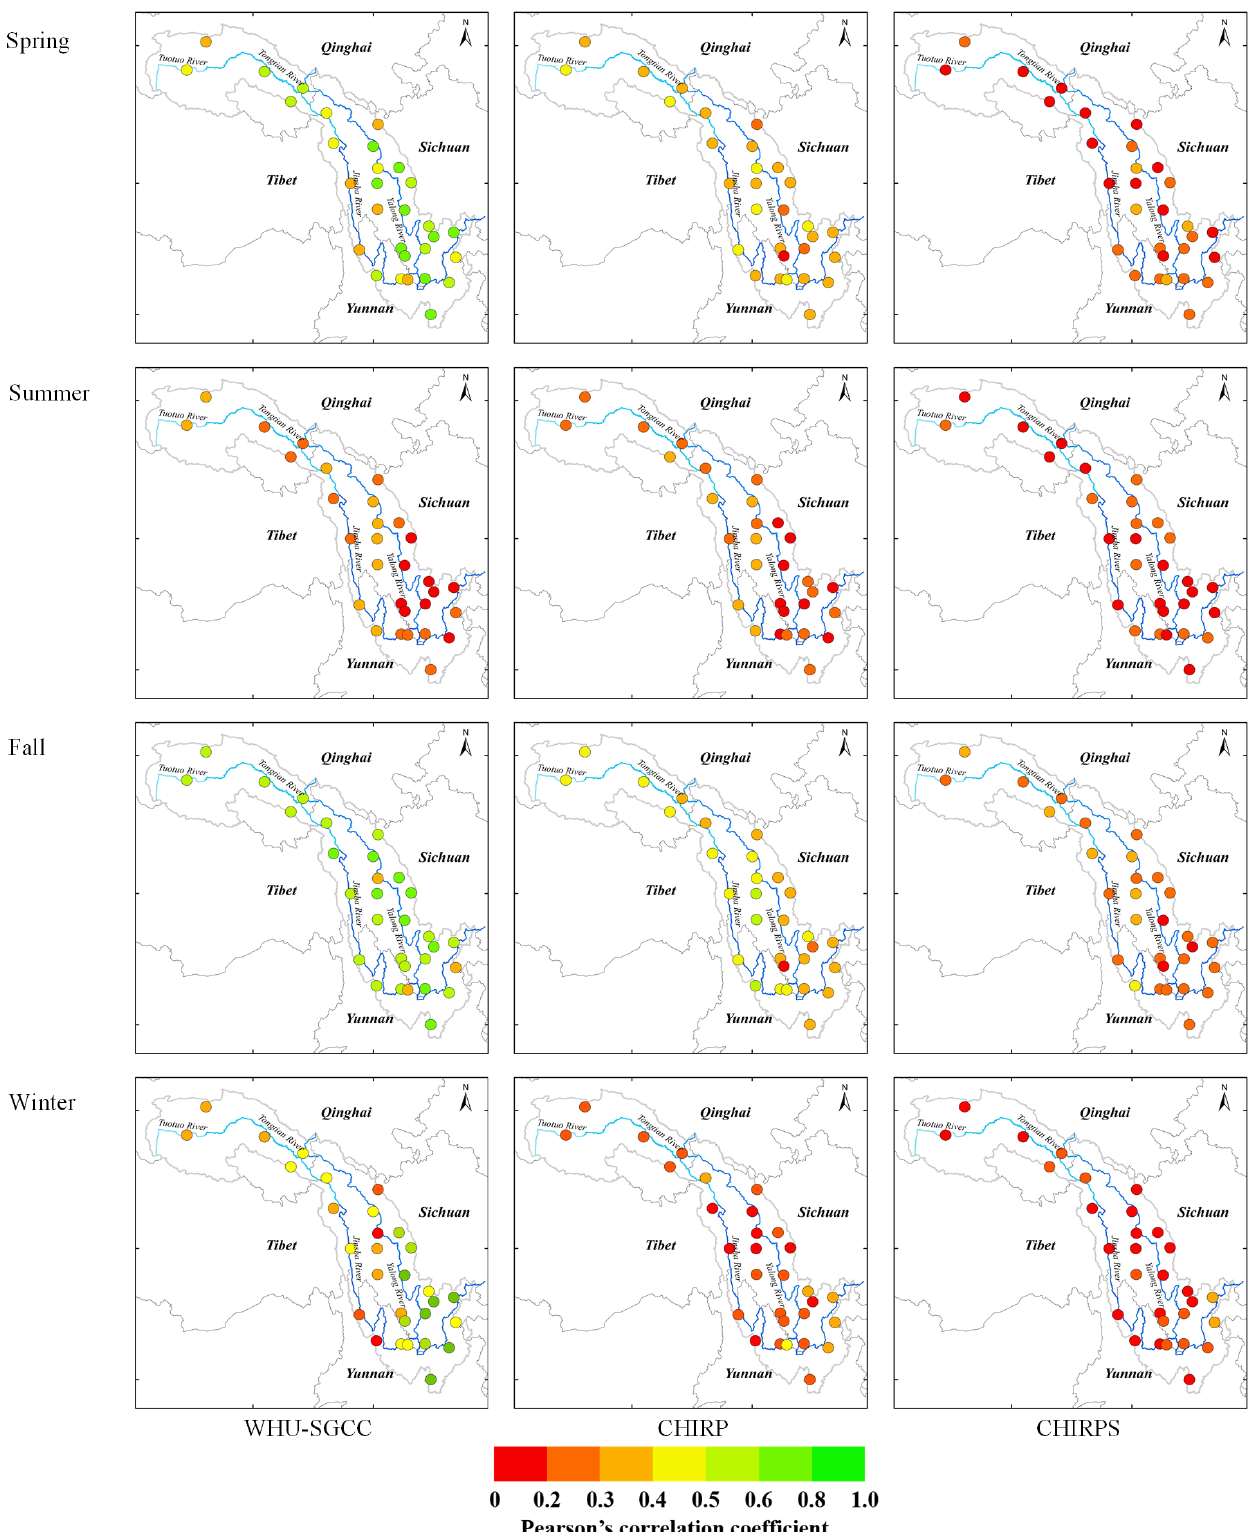
Figure 5. Spatial distribution of Pearson’s correlation coefficient of the overall agreement between observations and the WHU-SGCC, CHIRP, and CHIRPS estimations in the four seasons from 1990 to